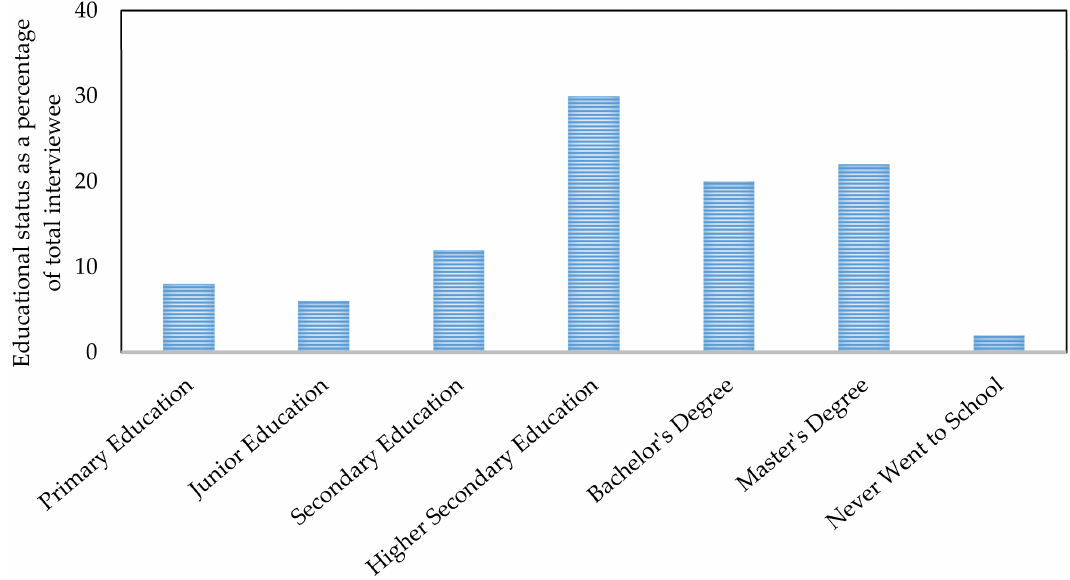
Figure 7. Educational status of interviewees as a percentage of total interviewed people.